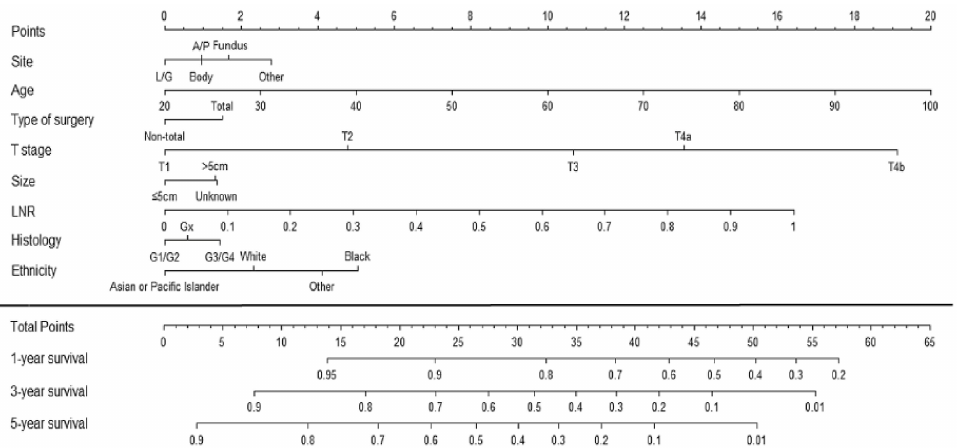
Figure 3. Predictive nomogram of survival after curative resection of gastric cancer, from Lu et al. [12]. Footnote: LNR = Lymph Node Ratio. Each of the included variables attributes a number of points according to the tumor and patient’s characteristics. The total addition of points provides the predicted percentage of 1-, 3- and 5- year survival